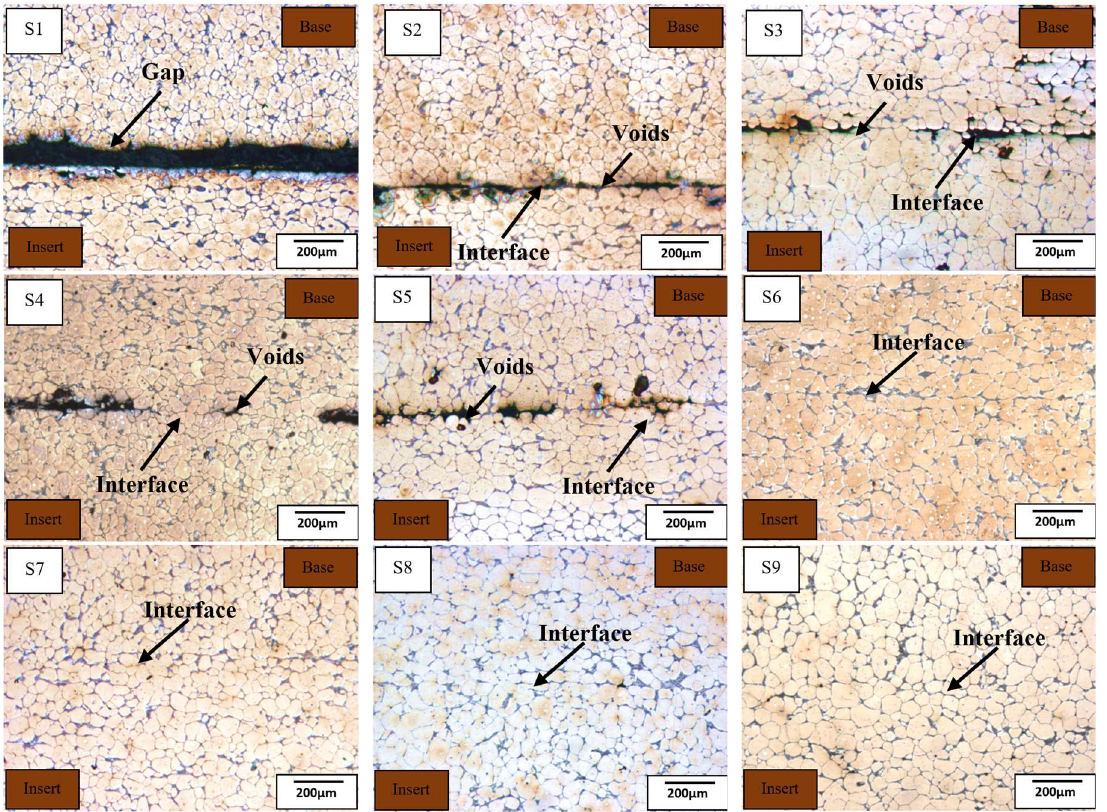
Figure 6. Microstructure of the thixojoined samples processed at different conditions: ( S1 ) 1250 °C/0 min, ( S2 ) 1250 C/5 min, ( S3 ) 1250 °C/10 min, ( S4 ) 1275 °C/0 min, ( S5 ) 1275 °C/5 min, ( S6 ) 1275 °C/10 min, ( S7 ) 1300 °C/0 min, ( S8 ) 1300 °C/5 min, ( S9 ) 1300 °C/10 min.